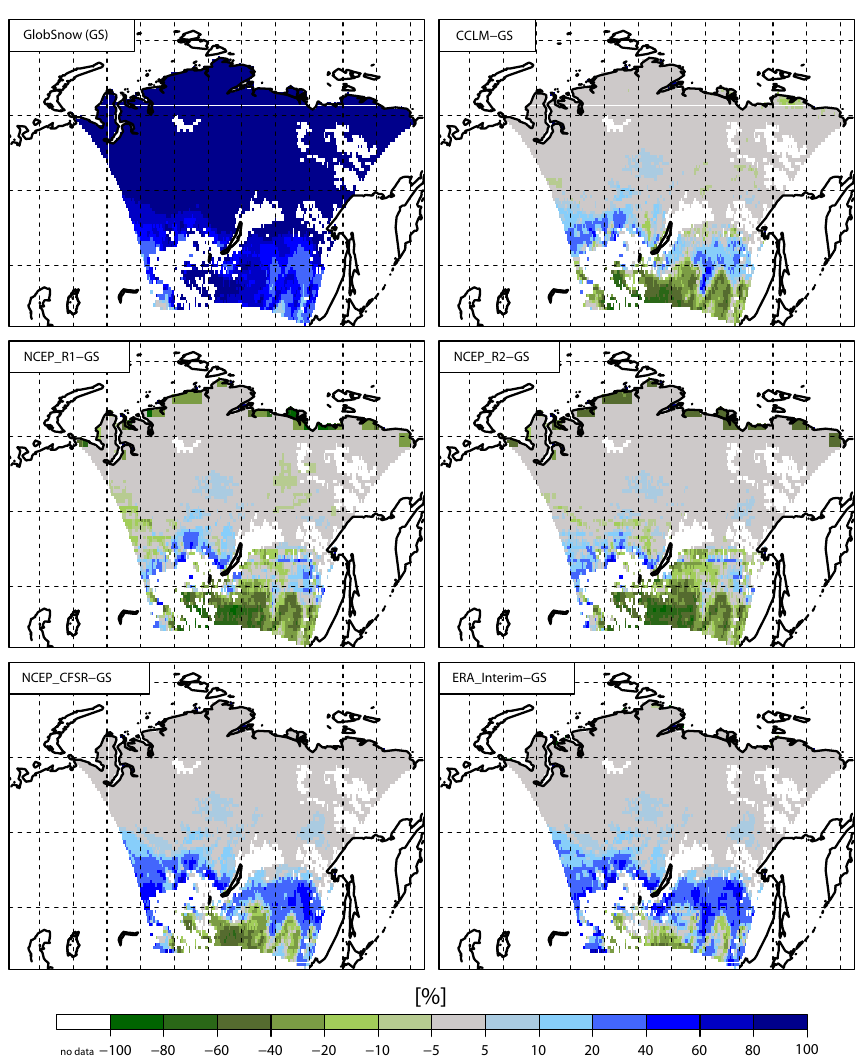
Fig. 2. Absolute frequency of snow covered days over land points of model domain during April between 1987–2010 for GlobSnow (upper row left) and differences for the remaining datasets against GlobSnow. White boxes within the model domain indicate missing values given by